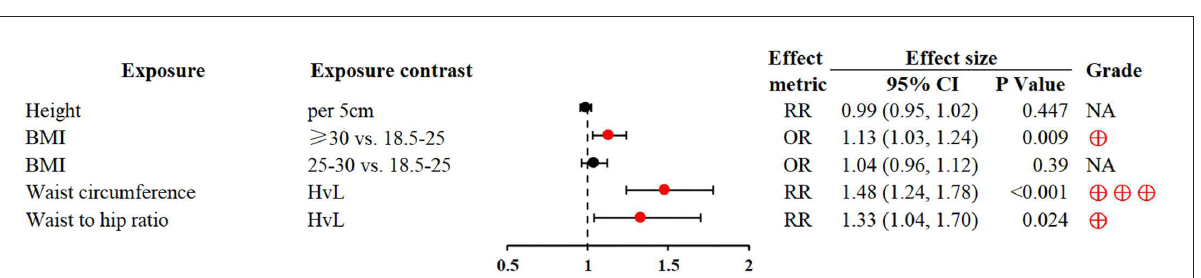
FIGURE2 Forest plot: summary effect estimates of meta-analyses reporting associations between GC and factors pertaining to anthropometric indices. BMI, body mass index; HvL, highest vs. lowest; NA, not applicable; red dots represent risk factors; blue dots represent protective factors;